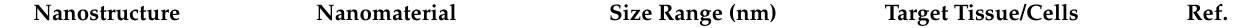
Table 1. Details of various nanostructures and their morphologies for targeting specific tissues or cells for retinal regeneration.